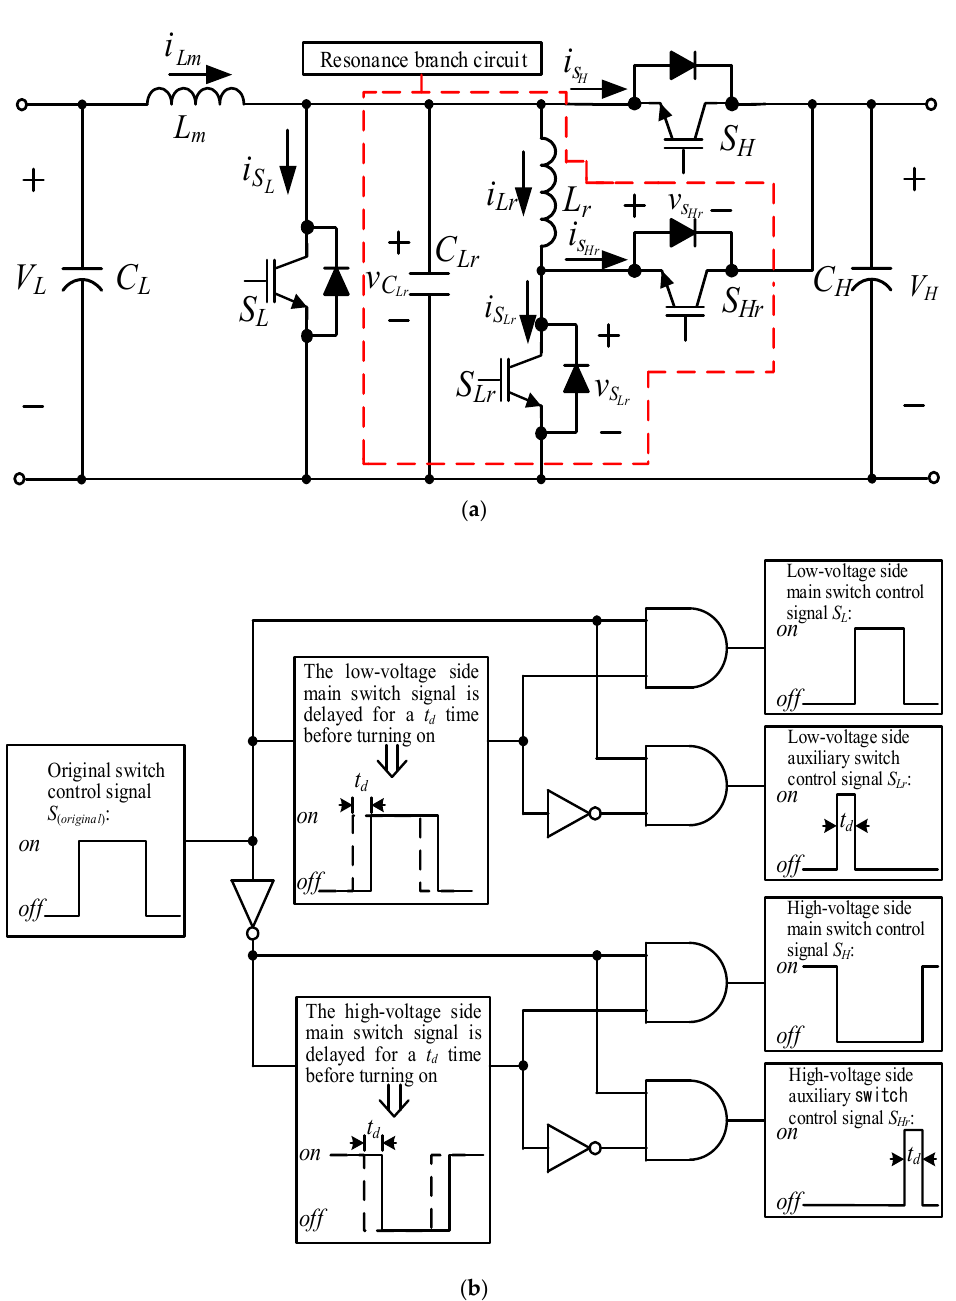
Figure 3. The bidirectional buck–boost soft-switching converter: ( a ) circuit architecture; ( b ) schematic diagram of switch signal output control.